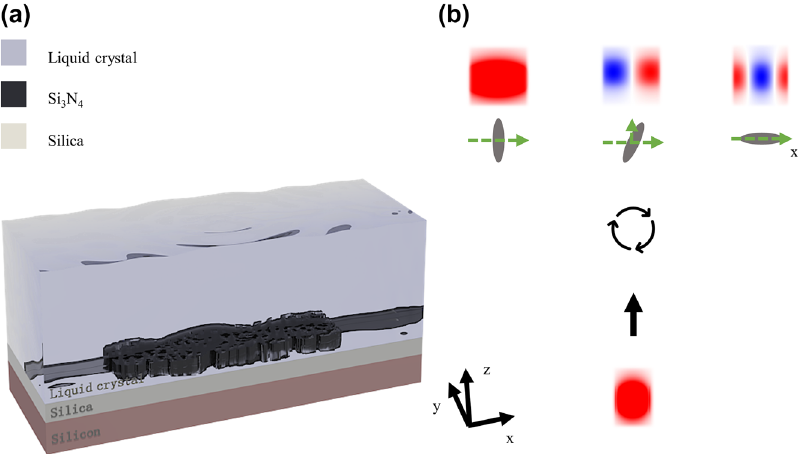
to TE (TE to TE , TE to TE ) mode converter with the 1 μ m wide 0 0 0 1 0 2 mode can be converted to the TE mode when the LC director is aligned 0 2 mode when the LC director 0